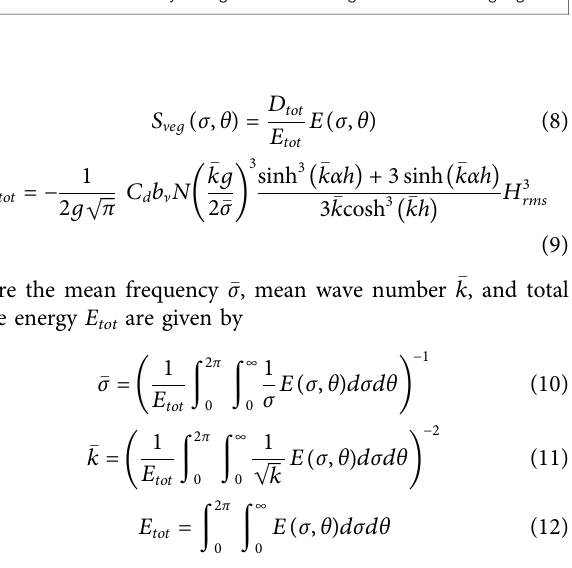
FIGURE 4 | Sensitivity of the model to vegetation characteristics ( C d , b v , l s ,and N ,normalizedbytheobservedvalues)forCase1(see Table1 )interms ofmeanerrornormalizedbythesigni fi cantwaveheightvalueatthe5thgauge.